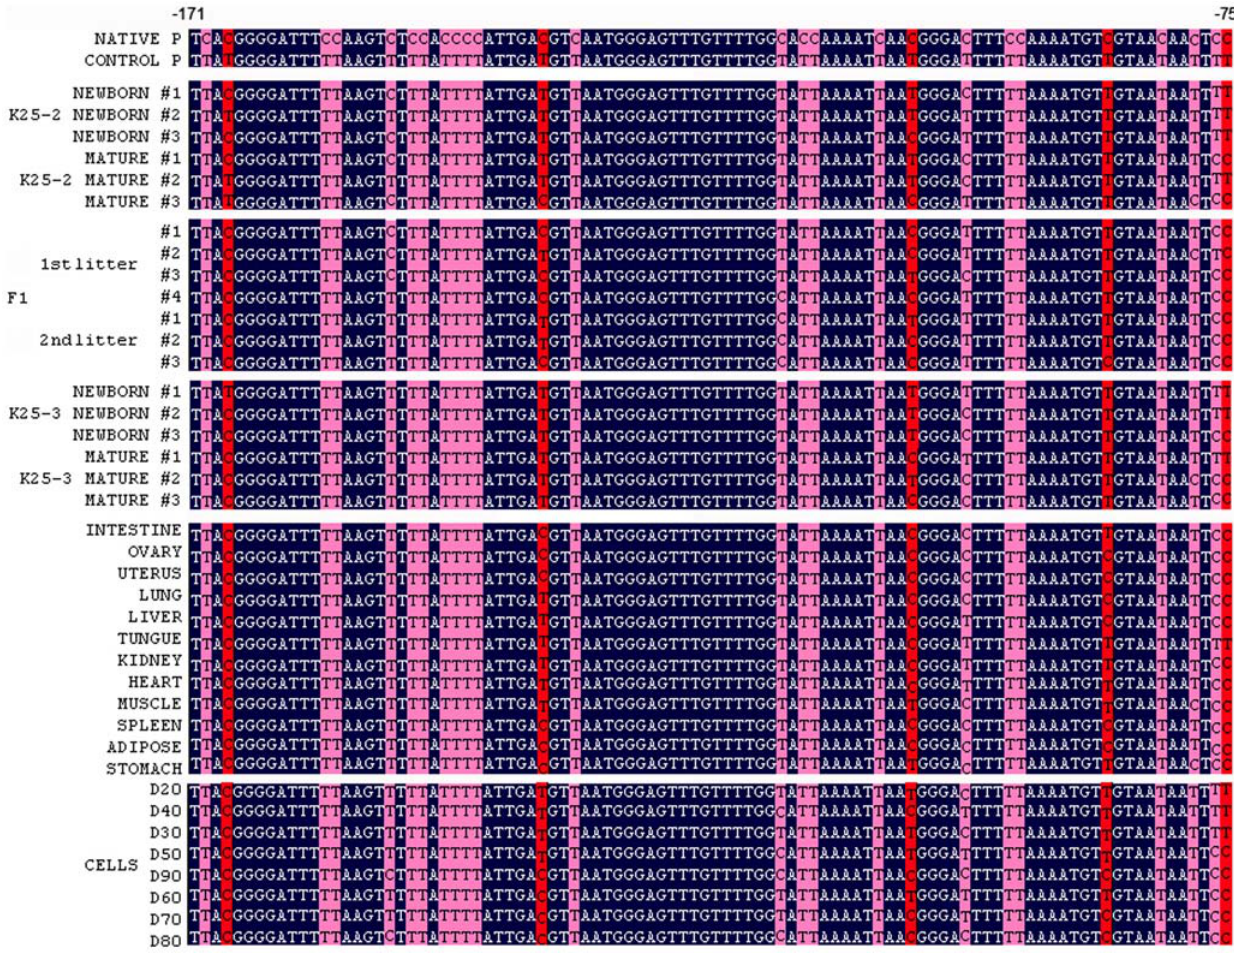
Figure 4. Bisulfite sequence data for a representative region of CMV promoter. Native P is the native sequence of the CMV promoter. The sequences from clones obtained after bisulfite treatment of DNA samples were aligned to the native sequence. For example, in control P cytosine residues were not methylated and therefore converted to thymidine by the bisulfite treatment. CpG and non-CpG cytosines were highlighted on a red and pink background,